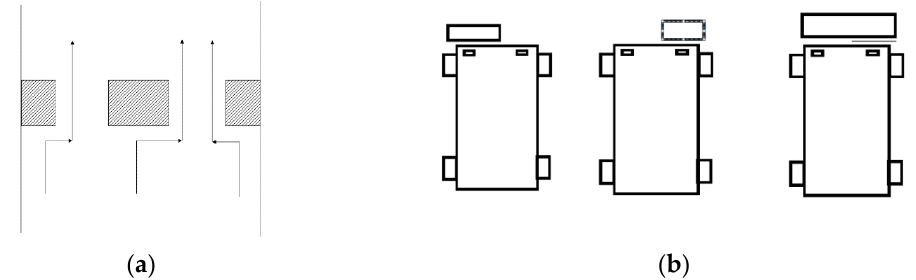
Figure 7. Schematic diagram of obstacle, ( a ) is the raised obstacle on the ground; ( b ) is a sunken obstacle on the ground.